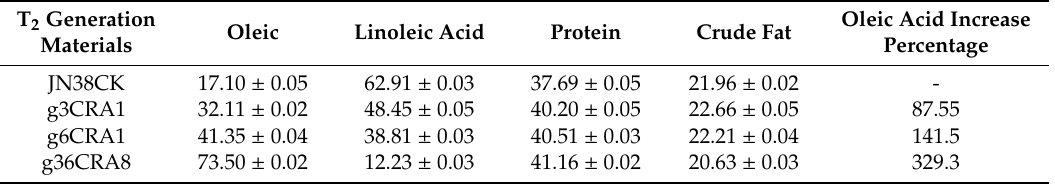
Table 2. Changes in fatty acid composition of positive T2 generation strains.